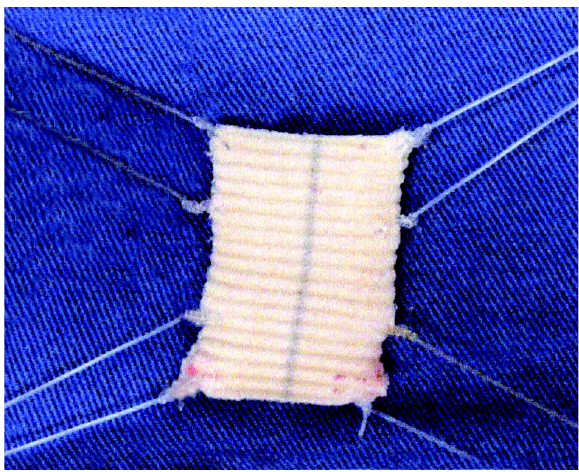
Figure 1 – Aspect of the sling ready for implantation.